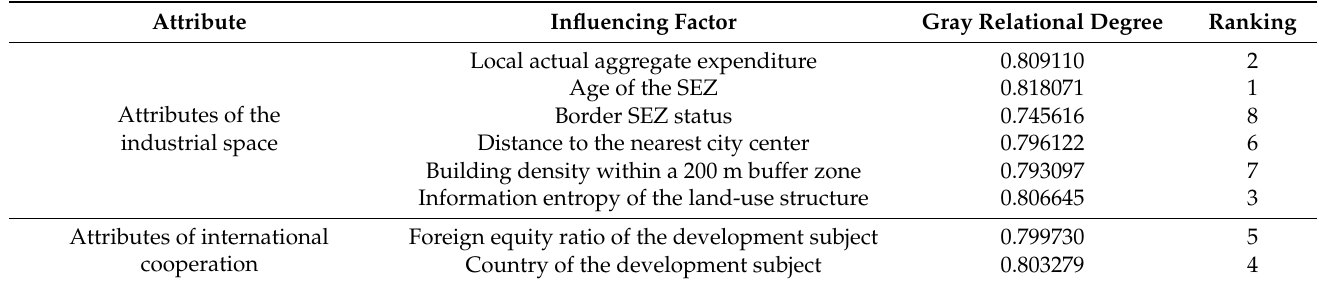
Table 5. Gray relational degree between the land-use efficiency and various factors in Laos’ SEZs in 2018. Attribute Influencing Factor Gray Relational Degree Ranking